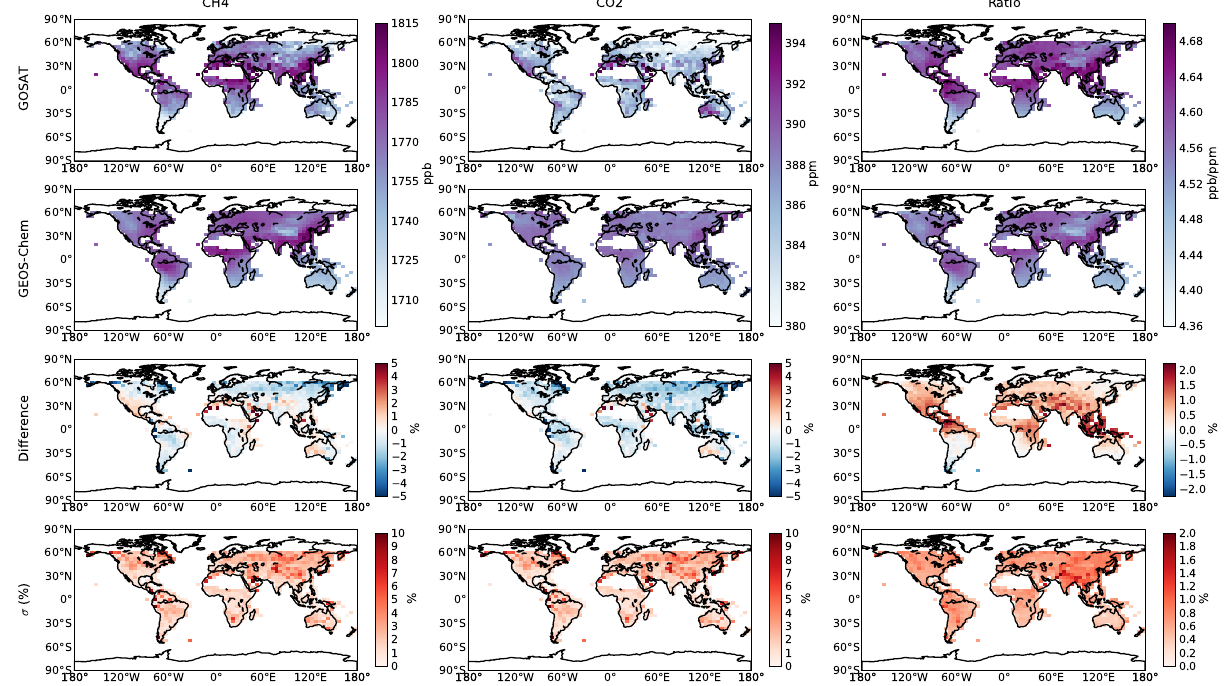
Figure 4. Annual mean GOSAT (top row) and GEOS-Chem model (second row) XCH 4 , XCO 2 , and XCH 4 : XCO 2 ratio measurements from GOSAT during 2010 averaged on the model 4 ◦ × 5 ◦ grid. The third row shows the percentage difference between them (GOSAT minus GEOS-Chem). For XCH 4 and XCO 2 , we truncate at the mean ± 2- σ . The bottom row shows the 1- σ value in the difference as a percentage about the annual mean GOSAT XCH 4 , XCO 2 , and XCH 4 : XCO 2 data. The model has been sampled at the time and location of the GOSAT observations, and convolved with scene-dependent averaging kernels.